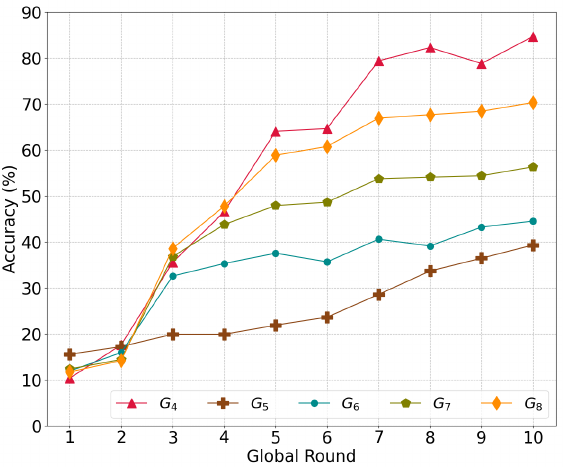
Figure 6. The accuracy of the global model depends on the proportion of local models to global models.